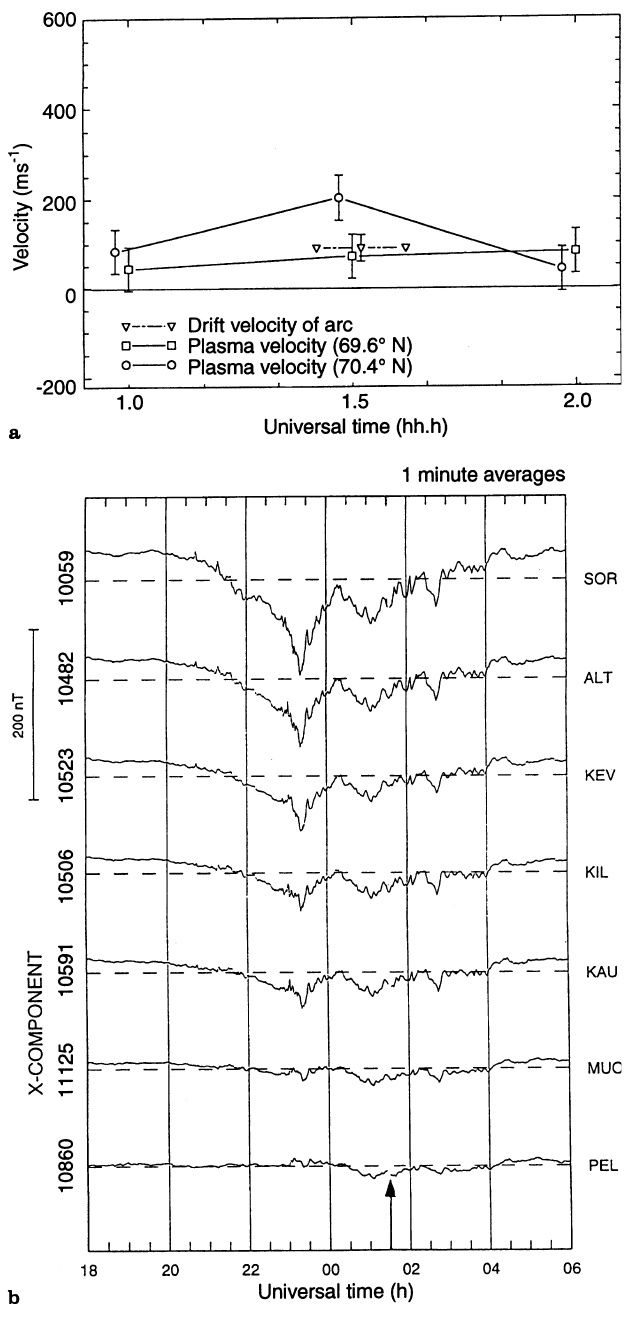
Fig. 7. a Comparison of arc drift velocity (indicated by broken line ) and plasma velocity in the same direction at two latitudes (indicated by continuous lines ) for 8 December 1988. b X-component of magnetograms from the IMAGE network for 7–8 December 1998. The arrow indicates the time at which the arc